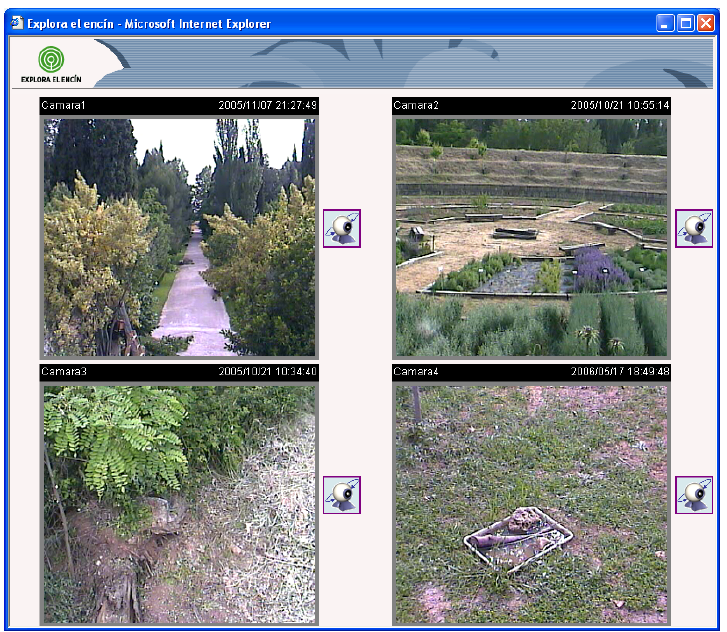
Figure 10. Main web page.